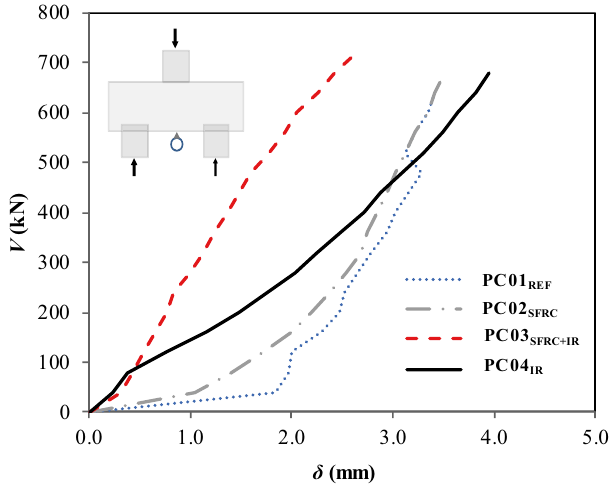
Figure 9. Load–displacement ratio .